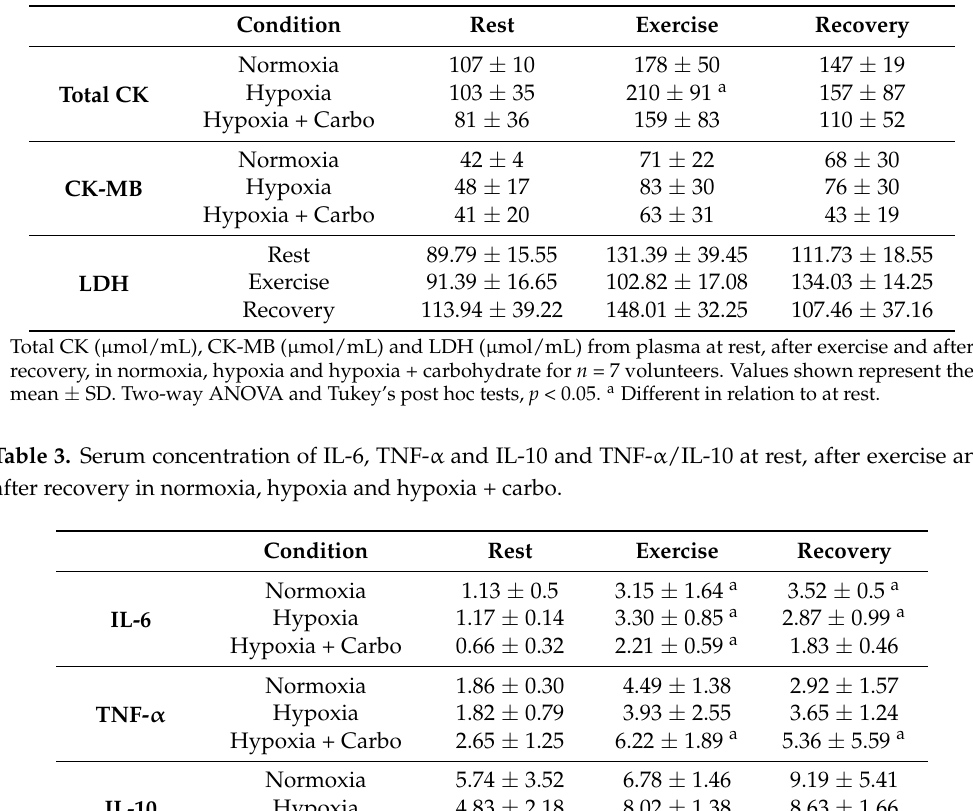
Table 2. Cellular damage at rest, after exercise and after recovery in normoxia, hypoxia and hypoxia + carbo.